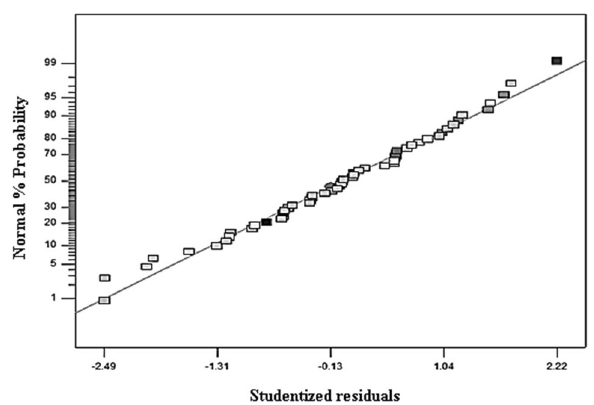
Figure 2. Normal plot of studentized residuals versus normal % probability for bearing the experiment for strontium ions.